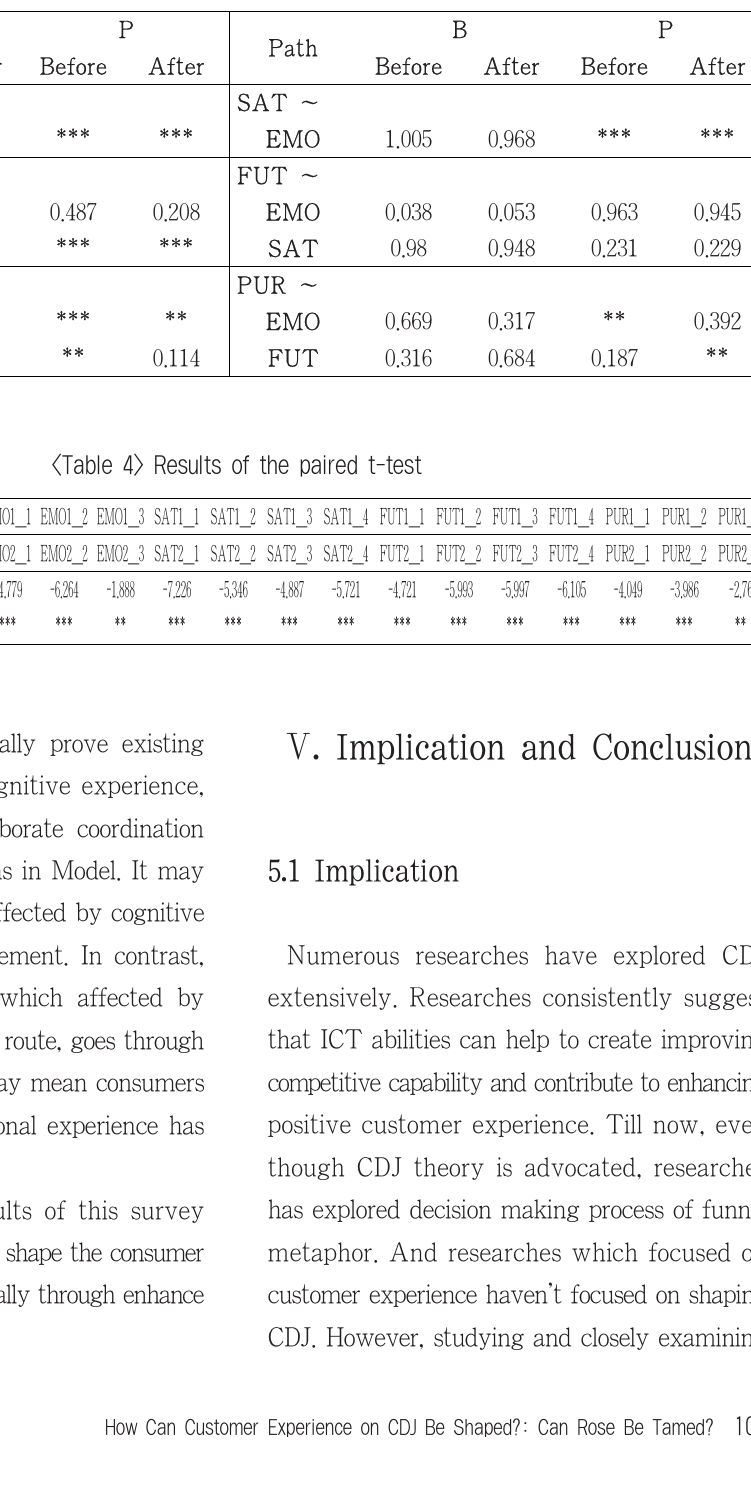
<Table 3> Paths coefficient and significance of the Models